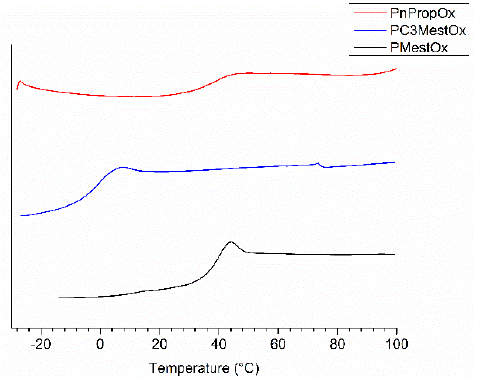
Figure 3. DSC traces of second heating run (10 K·min − 1 ) of PMestOx, PC3MestOx, and PnPropOx Figure 3. homopolymers.